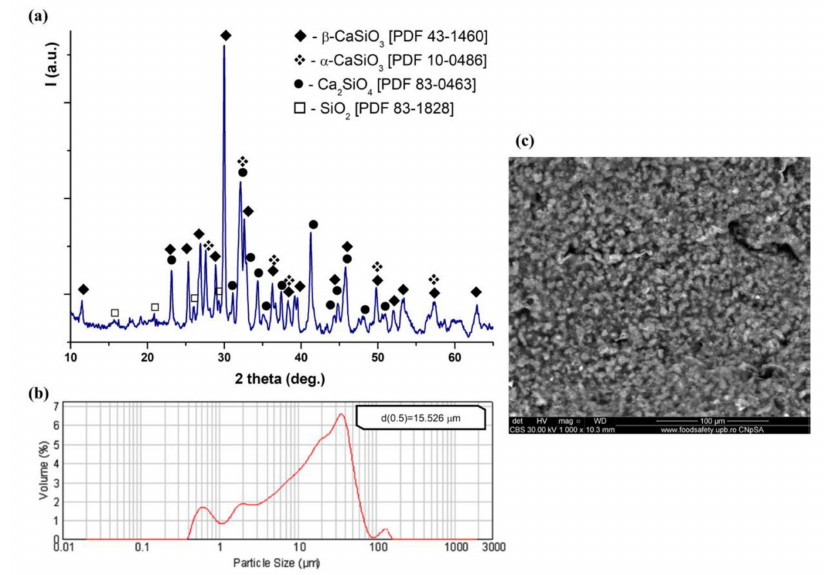
Figure 1. ( a ) The XRD pattern for the obtained CS powder; ( b ) the particle size distribution of CS powder; ( c ) the SEM micrograph representative for the CS phase (backscatter